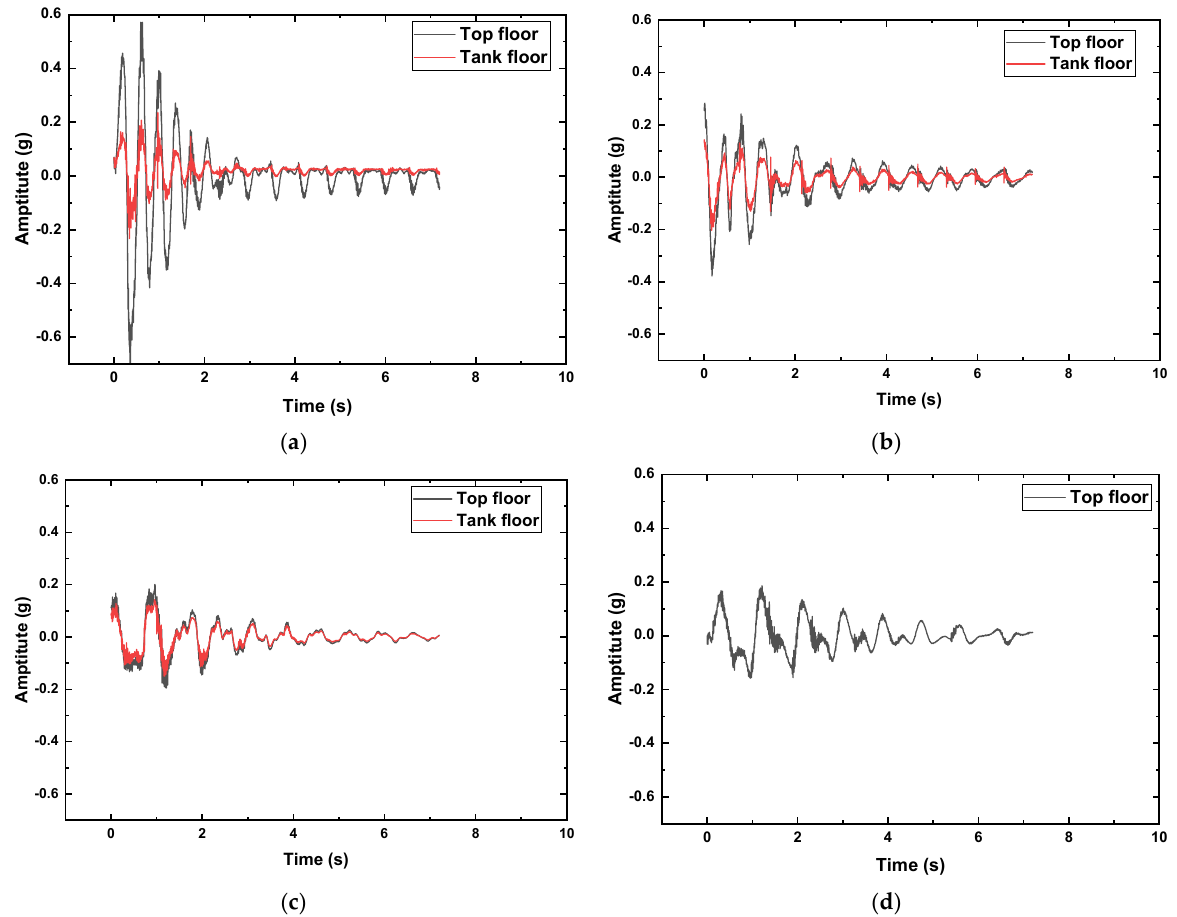
Figure 8. The accelerations when the water tank with a water level of 8 cm is placed on each floor of the structure. ( a ) 2nd floor; ( b ) 3rd floor; ( c ) 4th floor; ( d ) 5th floor. Table 1. The max acceleration amplitude considering the water tank with different water level placed on the different floor.